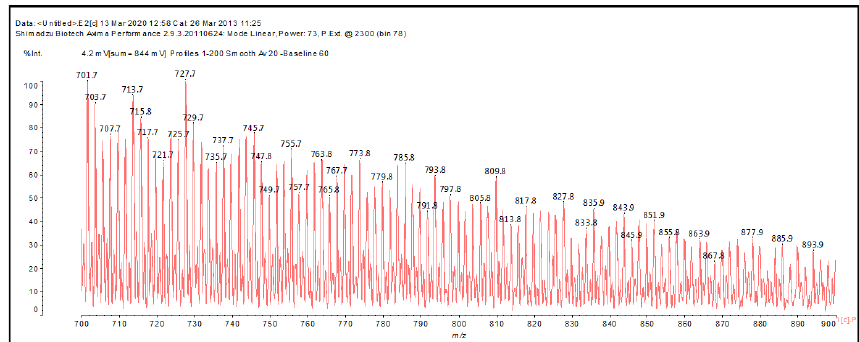
Figure 5. MALDI ToF spectrum of humins obtained at 180 °C from fructose, 700 – 900 Da range.